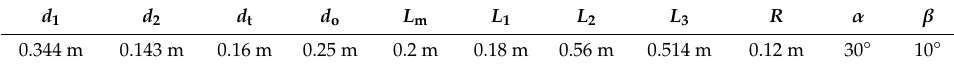
Figure 2. The geometry model of the annular multi-nozzle jet pump. Table 1. The dimensions of the geometry model.